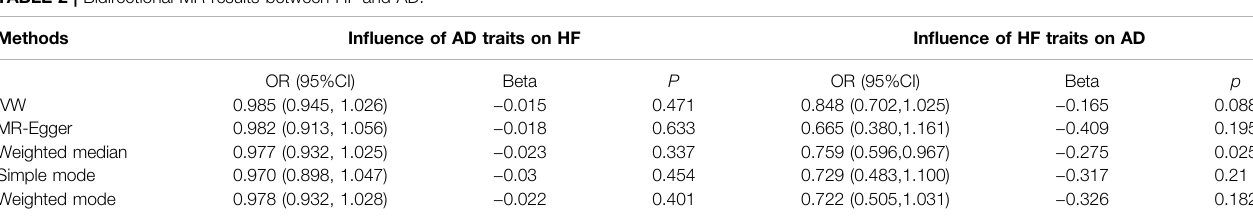
TABLE 2 | Bidirectional MR results between HF and AD.